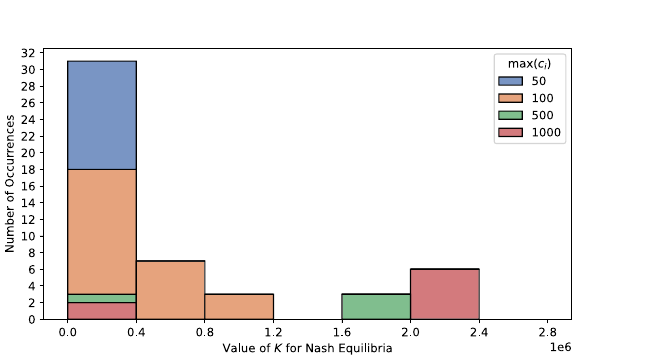
Figure 7. Change in Nash equilibrium with respect to max ( c i ) . The increase in max ( c i ) pushes the value of K that leads to Nash equilibrium from 0 to 0.4 million to around 2